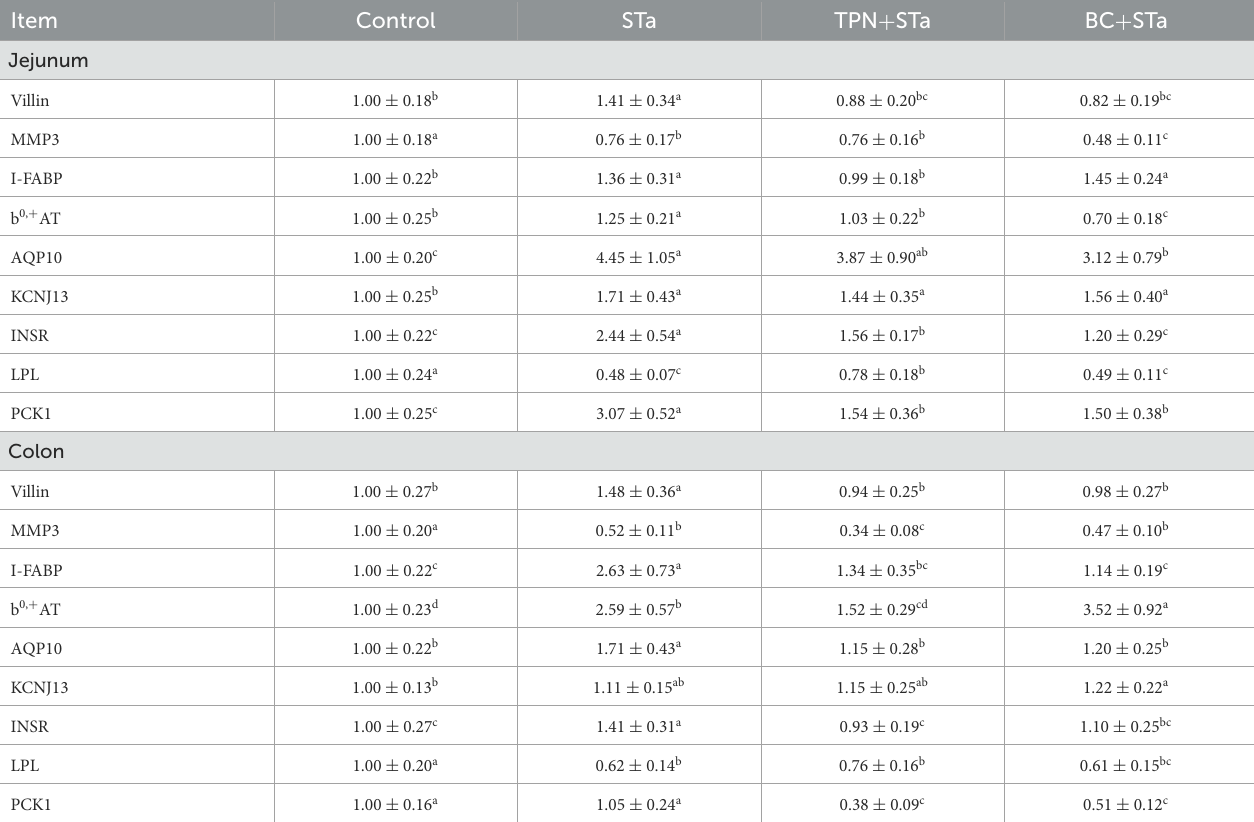
TABLE 6 Gene expression profiles in jejunum and colon.